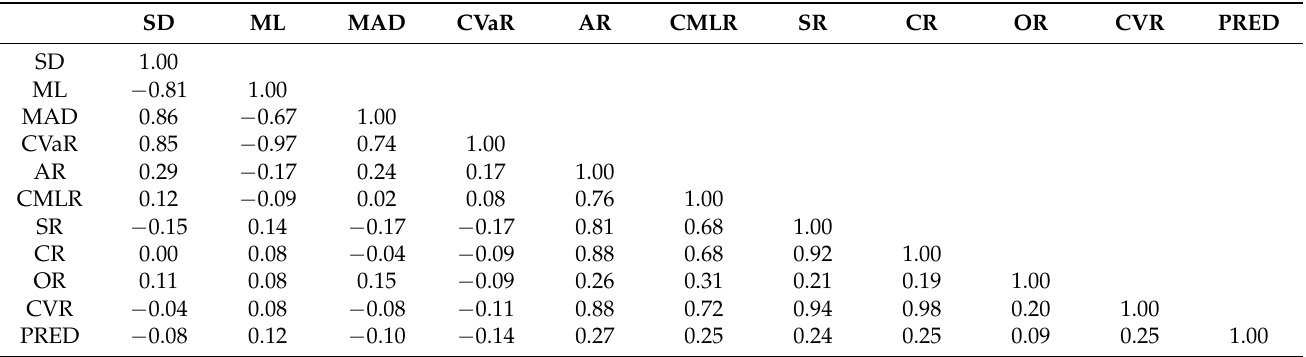
Table A1. Correlation matrix of